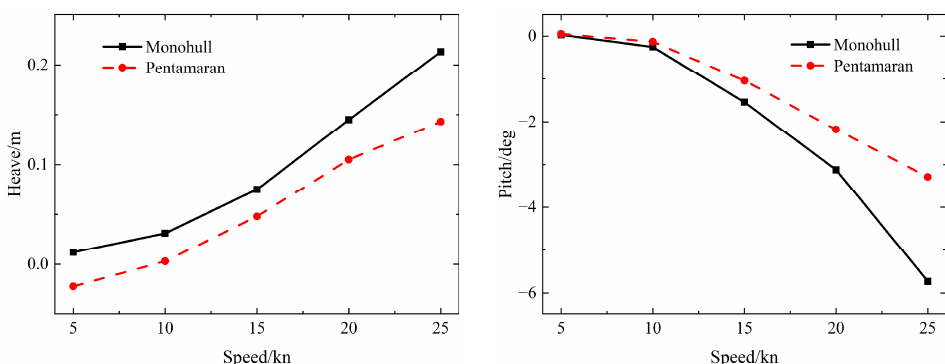
Figure 17. Heave and pitch in calm water.